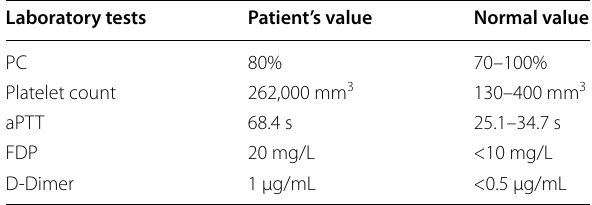
Table 1 Initial laboratory workup of an acquired hemophilia